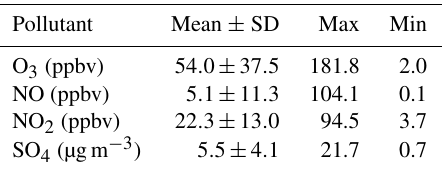
Figure 2. Pollution rose plot (openair) of particulate sulfate mea- sured by AMS for the sampling period, highlighting the wind con- ditions under which the highest concentrations of sulfate occur. Table 1. Supplementary anthropogenic pollutants measured during the sampling period analysed in this